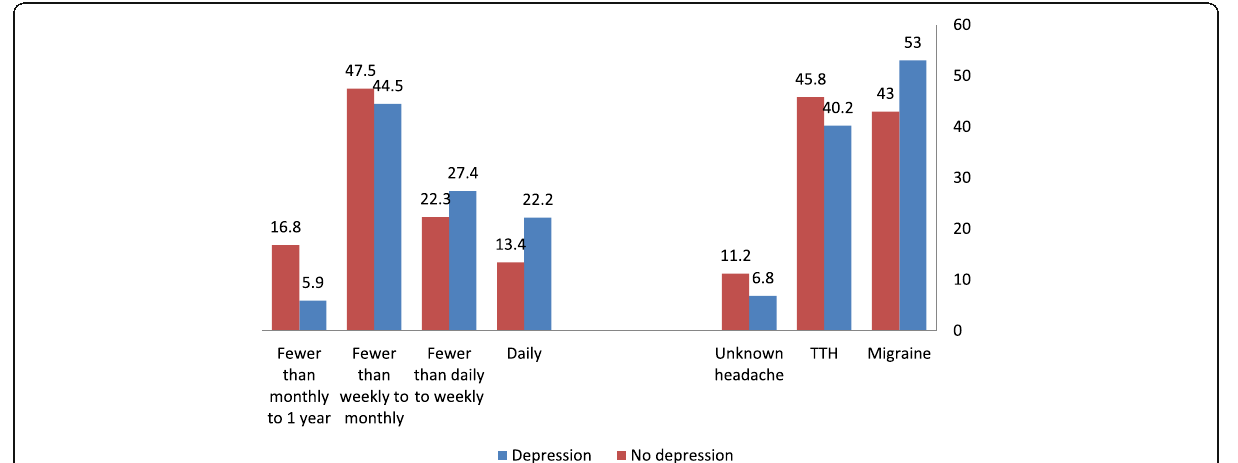
Fig. 2 Relationship between depression, headache types, and headache frequency. N.B. for headache types ( χ 2 = 11.1 and p value = 0.003). N.B. for headache frequency ( χ 2 = 26.6 and p value <